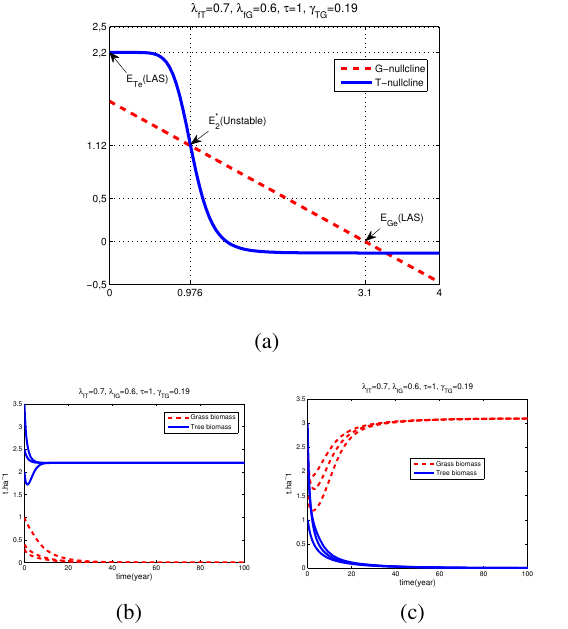
= = (0 . 84;2 . 2) and E G 1 e 1 ,